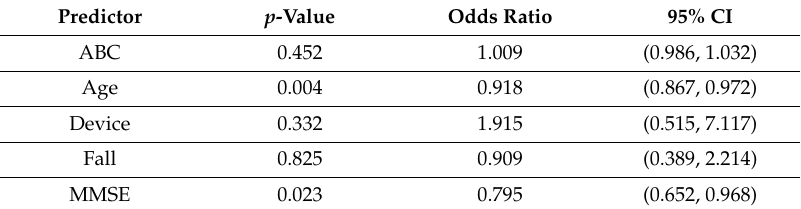
Table 5. Logistic regression analysis of improvement on CRT from Initial Visit to Follow-up Visit